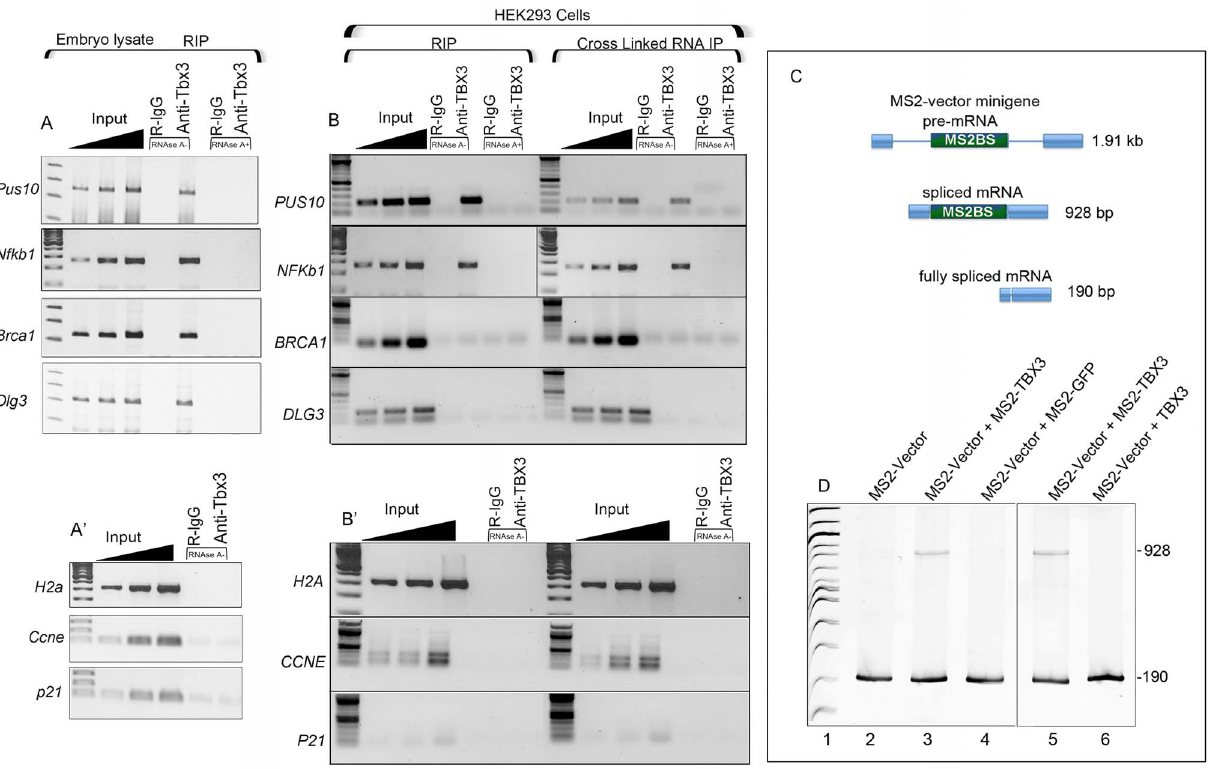
Figure 5. Endogenous Tbx3/TBX3 associates with specific mRNAs in mouse embryonic tissues and HEK293 cells. A, A 9 ) RNA-IP with anti-Tbx3 on embryo lysates in the presence or absence of RNAseA followed by RT-PCR for transcript detection. Tbx3 binds Pus10 , Nfkb1 , Brca1 and Dlg3 mRNAs. A 9 ) H2a, Ccn e and p21 are negative controls for the positive interactions seen in panel A, as Tbx3 does not bind/RIP these mRNAs. B, B 9 ) RIP and cross-linked RNA-IP (CLIP) of HEK293 lysates followed by RT-PCR. Endogenous TBX3 binds the PUS10 and NFKb1 mRNAs but not BRCA1 , DLG3 (B) or negative controls (B 9 ). C) Schematic of splicing products from a novel splicing reporter containing multimeric MS2 binding sites in exon 2 of the pRHCglo minigene (MS2-vector); the unspliced pre-mRNA (1.91 kb), partially (928 bp), and fully spliced (190 bp) products are shown. D) RT-PCR analysis to detect splicing products from the MS2 reporter RNA in HEK293 cells. In the presence of MS2-TBX3, a partially spliced mRNA is present consisting of exons 1–3, but no introns (927 bp, lanes 3, 5). MS2-GFP (lane 4) and wild type TBX3 (lane 6) have no